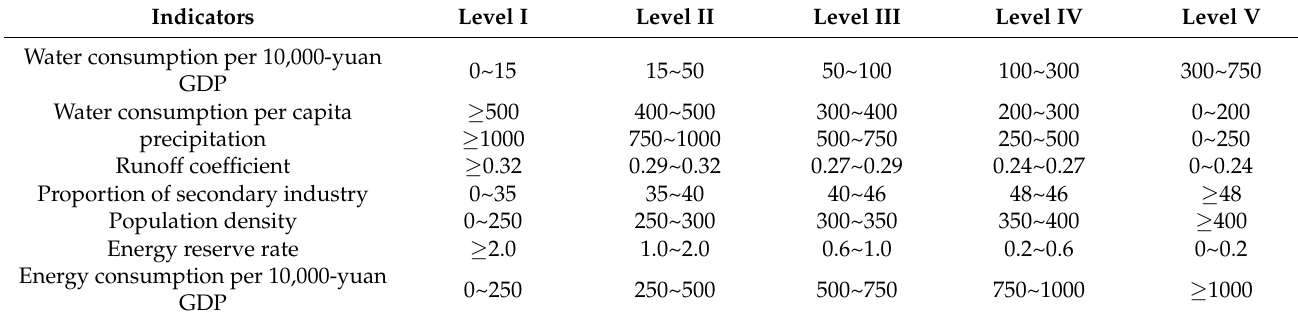
Table 3. Classification criteria for risk assessment indicators of water resources and energy